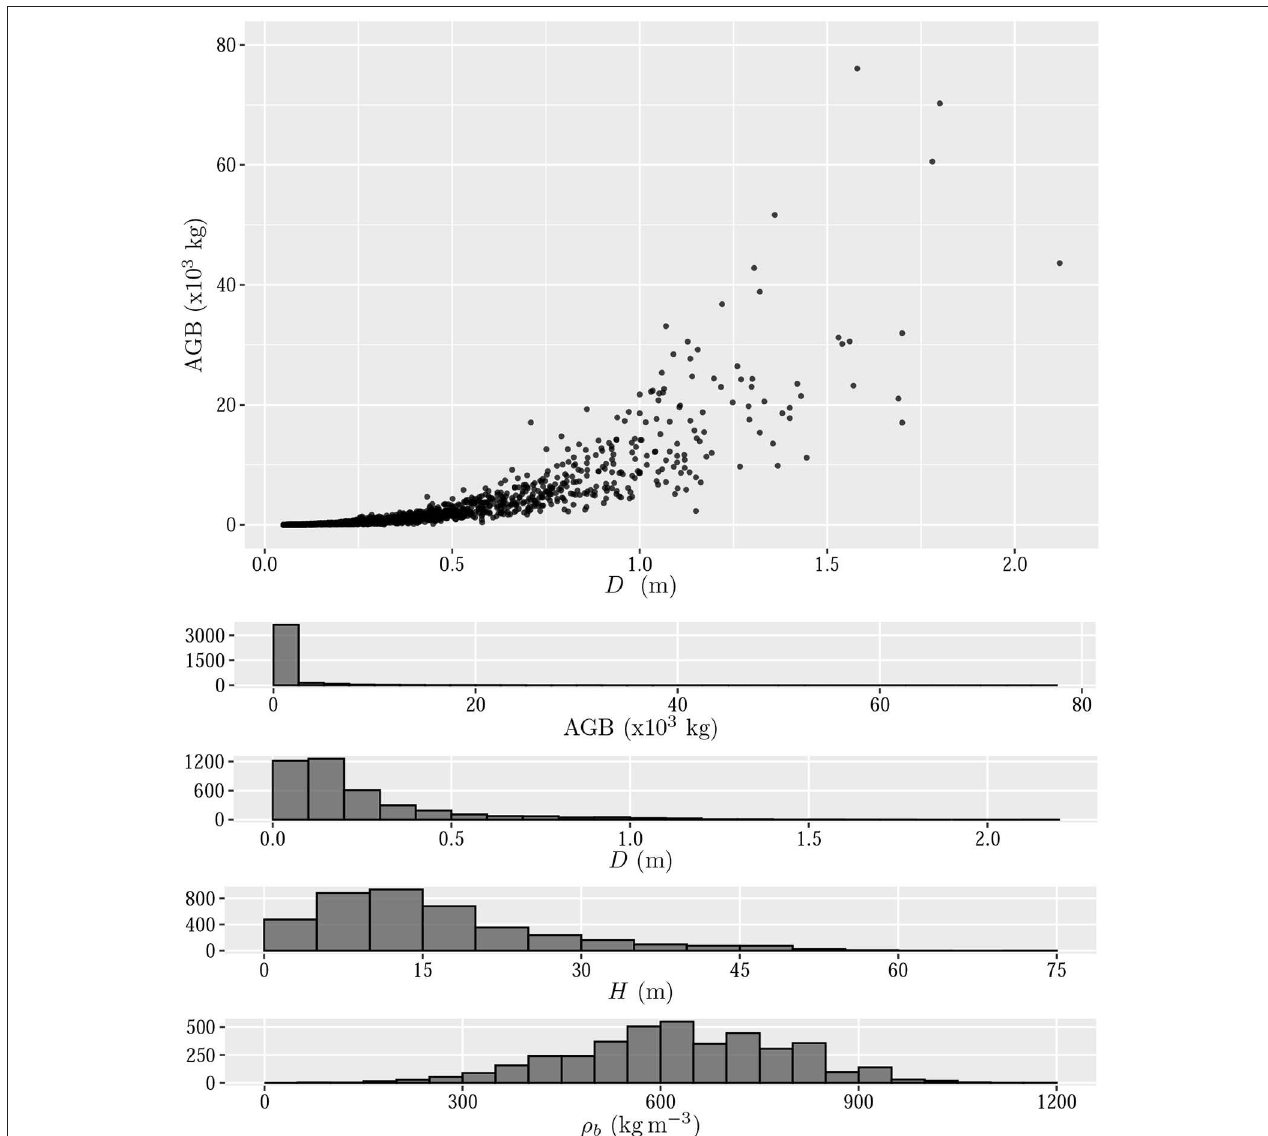
FIGURE 2 | Illustrations of the 4004destructively harvested trees comprising the Chave et al. (2014) compilation of pan-tropical calibration data. In the upper plot, AGB is plotted against D , the dominant predictor variable in most allometric models; it can be seen that variance in AGB is non–constant. The lower histograms present the distributions of the 4measured variables across these data. It is noted observations are non–uniformly distributed across the range of each variable, with the majority collected from relatively small trees.